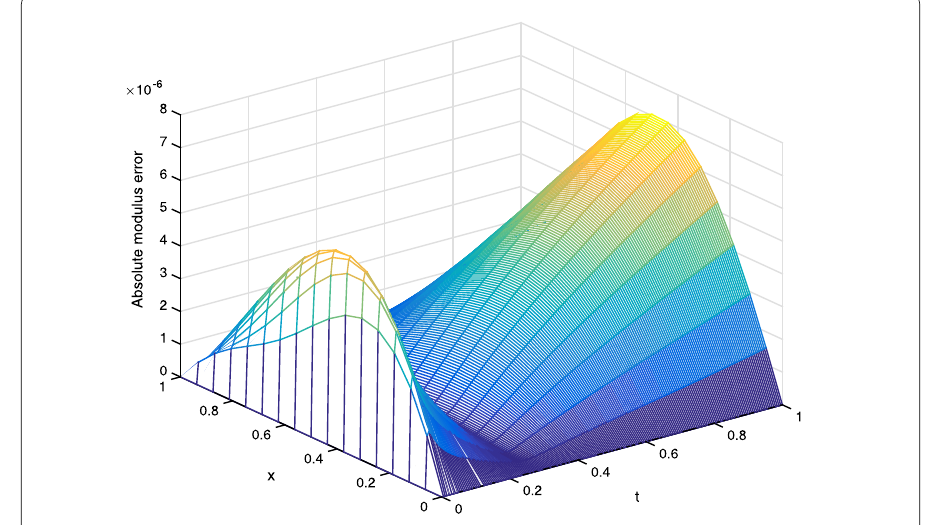
Figure 7 (Example 6.3) Absolute modulus error